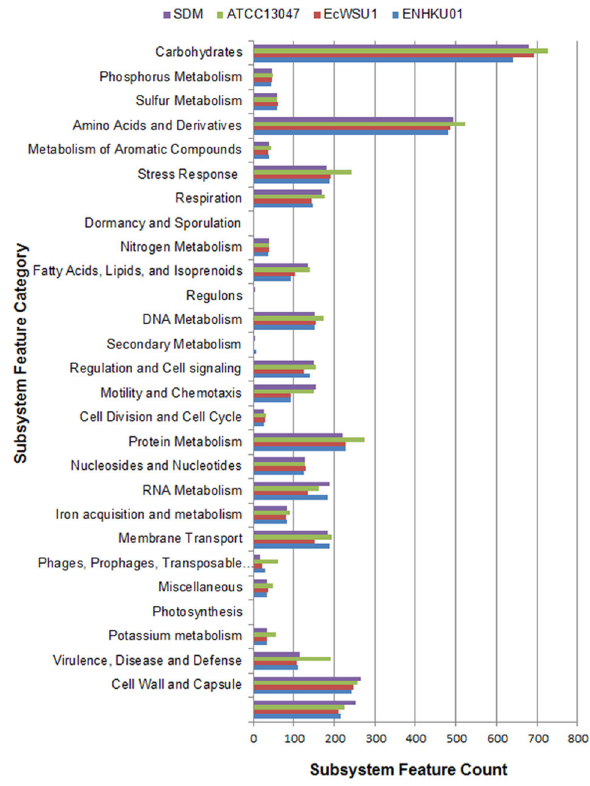
Table 2. Comparison of fimbriae in E. cloacae